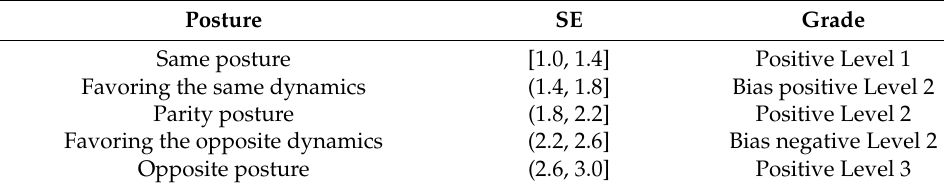
Table 2. Corresponding relation between set pair potential and levels. Posture SE Grade Same posture [1.0, 1.4] Positive Level 1 Favoring the same dynamics (1.4, 1.8] Bias positive Level 2 Parity posture (1.8, 2.2] Positive Level 2 Favoring the opposite dynamics (2.2, 2.6] Opposite posture (2.6, 3.0] Positive Level